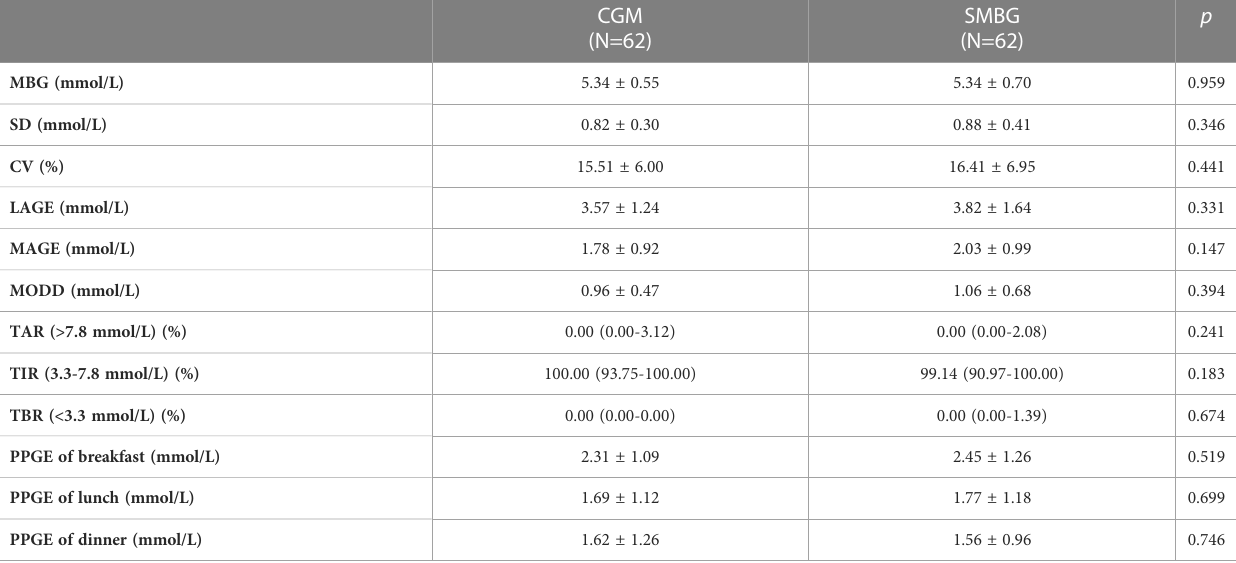
TABLE 2 Continuous glucose monitoring metrics after 8